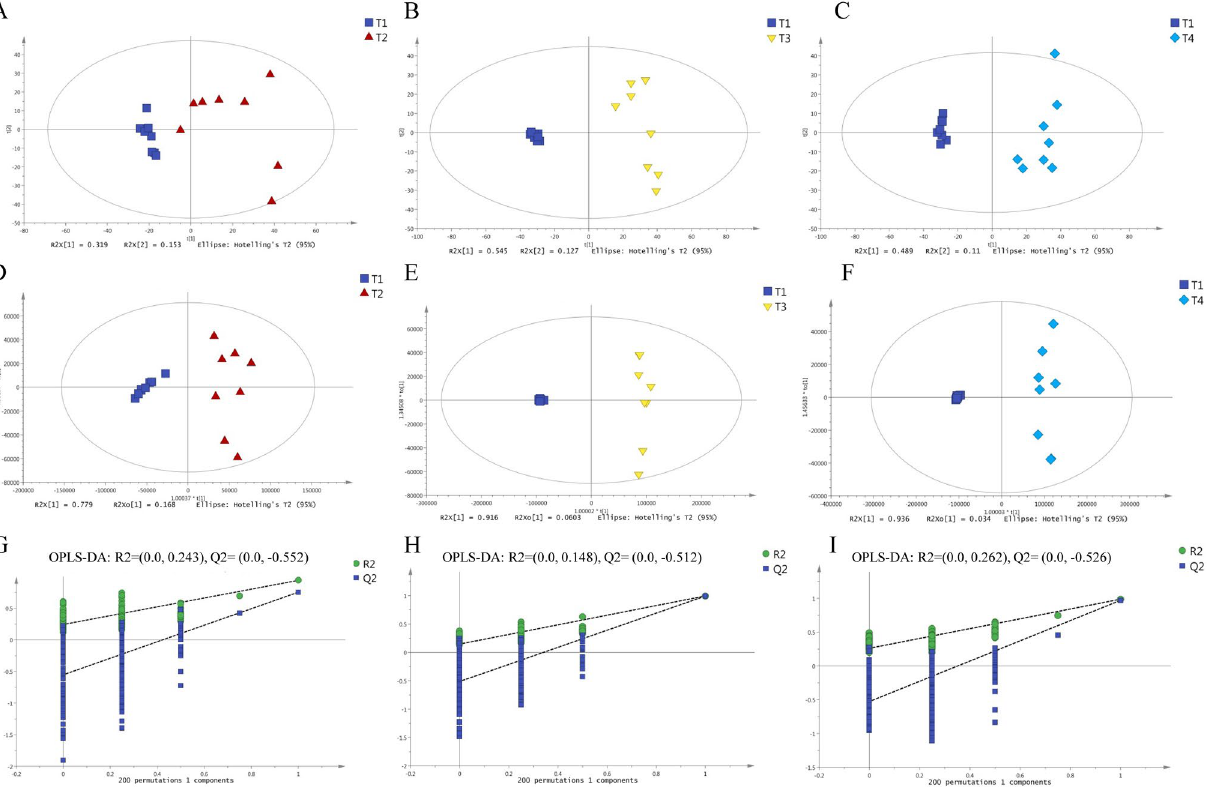
Figure 1. Analysis of lipid accumulation at different stages of kernel development in Paeonia ostii. ( A – C ) PCA plots, showing ( A ) T1 as compared to T2, ( B ) T1 as compared to T3, and ( C ) T1 as compared to T4. ( D – F ) OPLS-DA plots, showing ( D ) T1 as compared to T2, ( E ) T1 as compared to T3, and ( F ) T1 as compared to T4. ( G – I ) Permutation tests of the OPLS-DA plots (200 random permutations), showing ( G ) T1 as compared to T2, ( H ) T1 as compared to T3, and ( I ) T1 as compared to T4. R2 (downregulate squares) indicates the goodness of fit of each OPLS-DA model, while Q2 (green circles) reflects the predictive value of each model, based on the percentage of the correctly classified samples during cross-validation. Regression lines for R2 and Q2 are shown in each